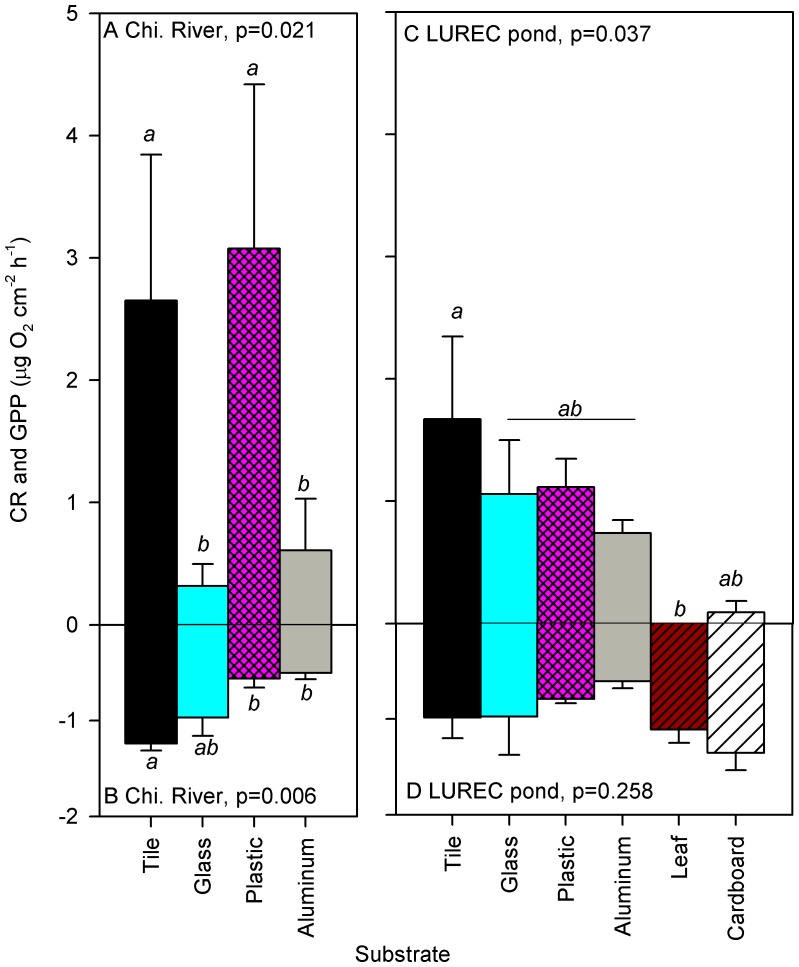
Mean (±SE) gross primary production (GPP) and community respiration (CR) for biofilms colonizing natural substrates (unglazed ceramic tile and leaves) and anthropogenic litter substrates including glass, hard plastic, aluminum, and cardboard incubated in (A) North Branch of the Chicago River, and (B) a pond at Loyola University Retreat and Ecology Campus (LUREC; N = 3 for each substrate at each site).Results (p-values) from 1-way ANOVA among substrates for each metric are shown in each panel, small letters indicate significant differences among substrates (p<0.05) as indicated by Tukey's multiple comparison test.